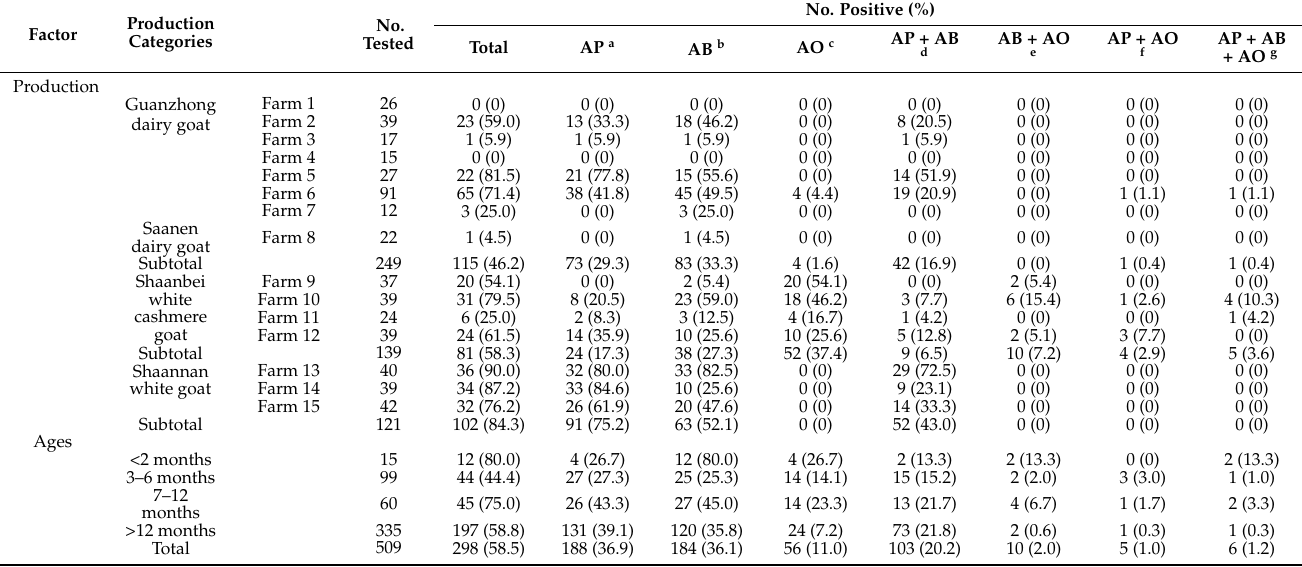
Table 3. Occurrence of Anaplasma spp. in dairy, cashmere, and meat goats in Shaanxi province.